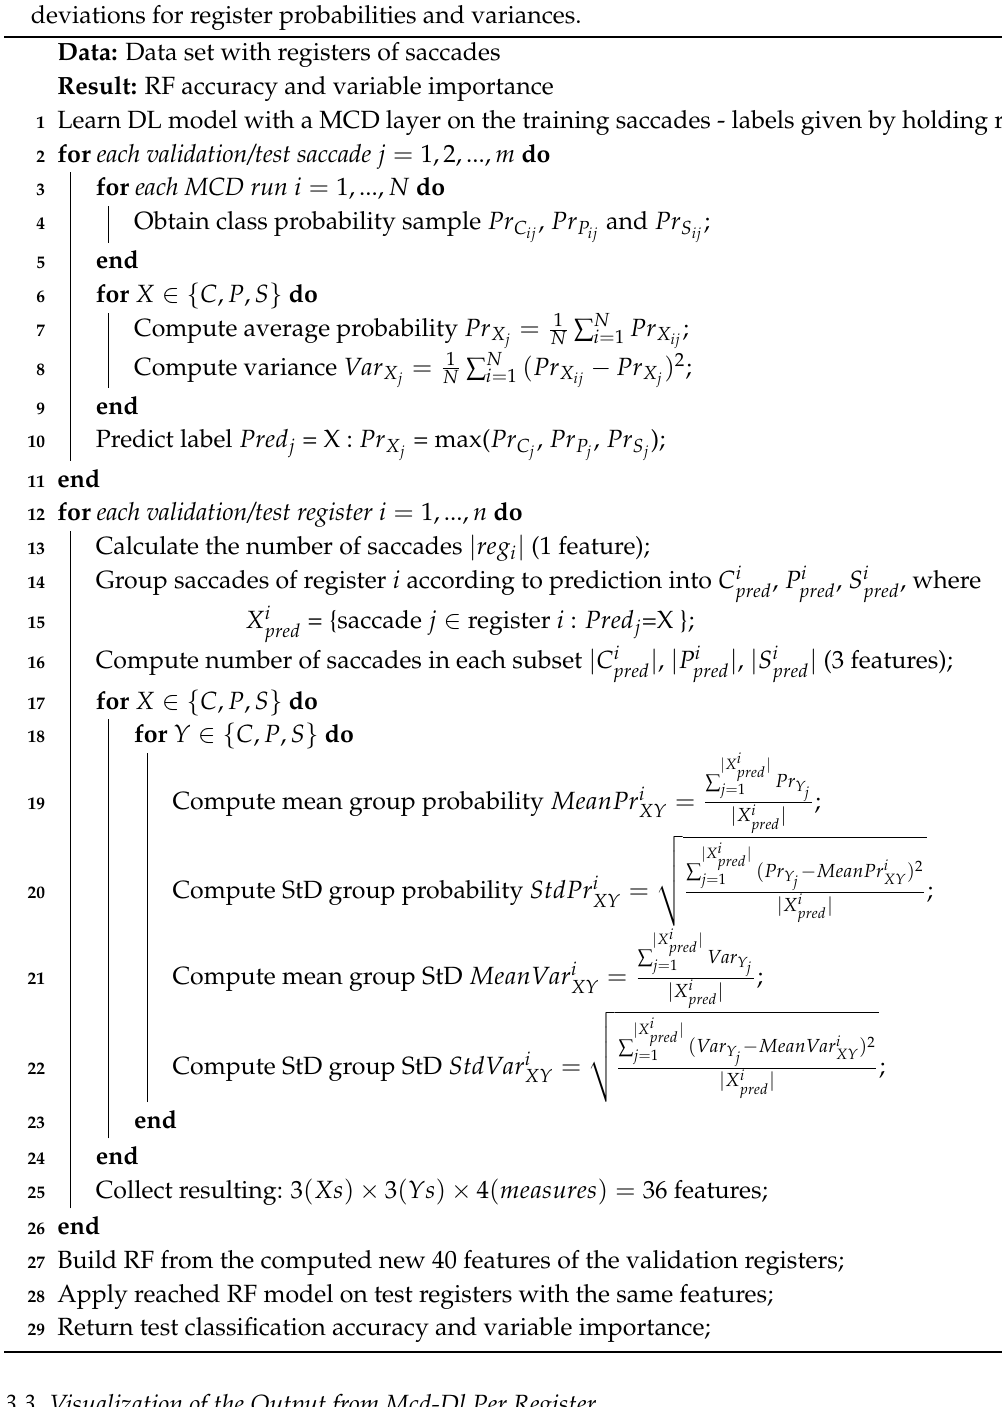
Algorithm 1: The MCD-DL-RF model: MCD sample output for saccades from DL, computation of the uncertainty estimates over registers and RF construction from the means and standard deviations for register probabilities and